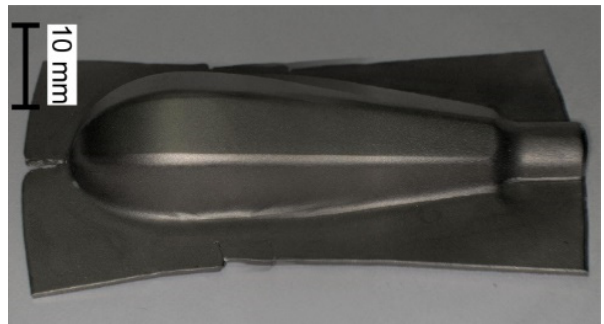
Figure 13. View of drawn part formed in presence of lubricant and blank holder.